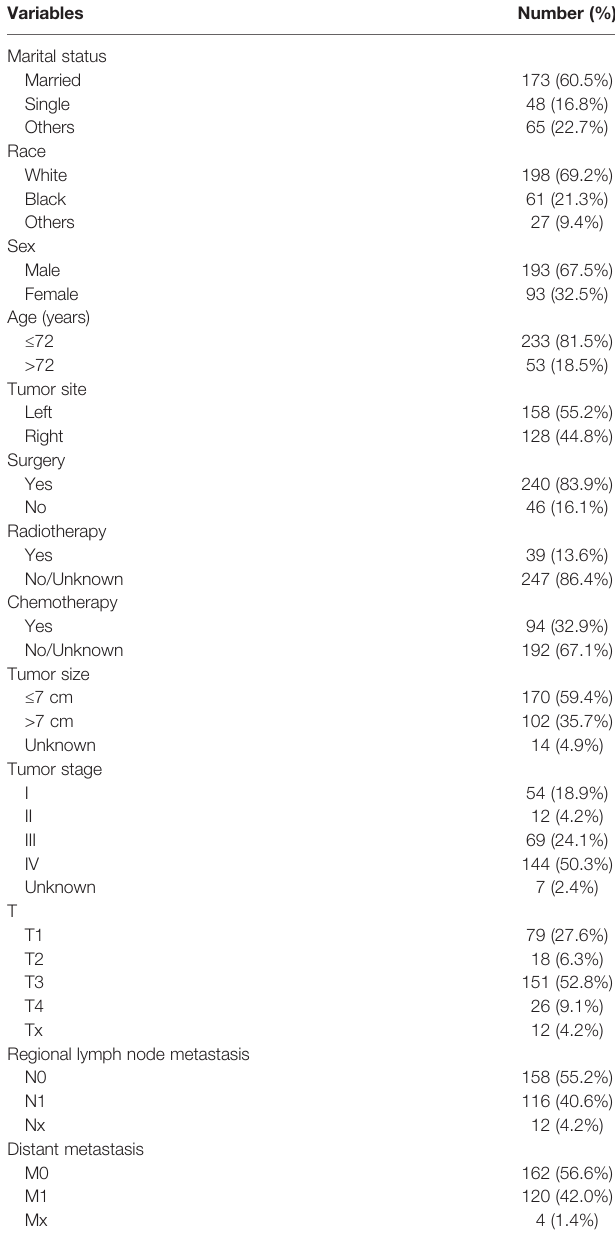
TABLE 1 | Descriptive data of patients with